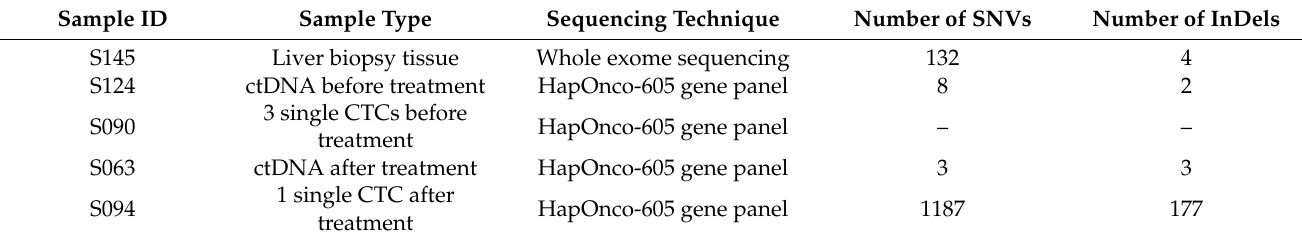
Figure 4. Schematic illustration of the diagnosis, treatment and sample collection of a representative advanced lung cancer patient (patient #1). Table 2. Sequencing information of samples from patient #1.